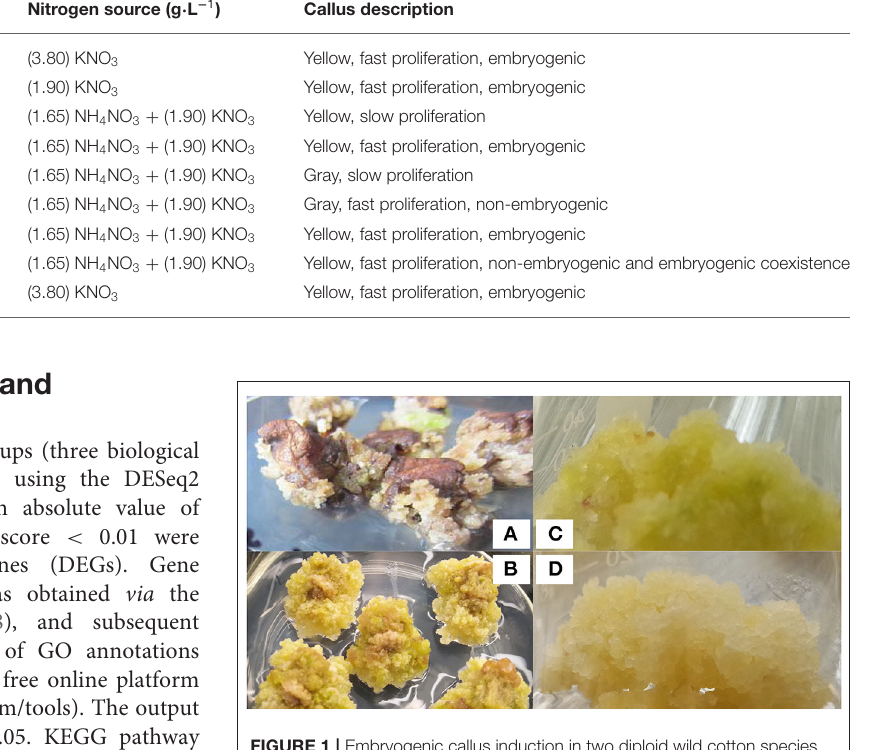
loose, slight color differences were observable (i.e., yellow-green vs. light yellow, for G. sturtianum and G. raimondii,